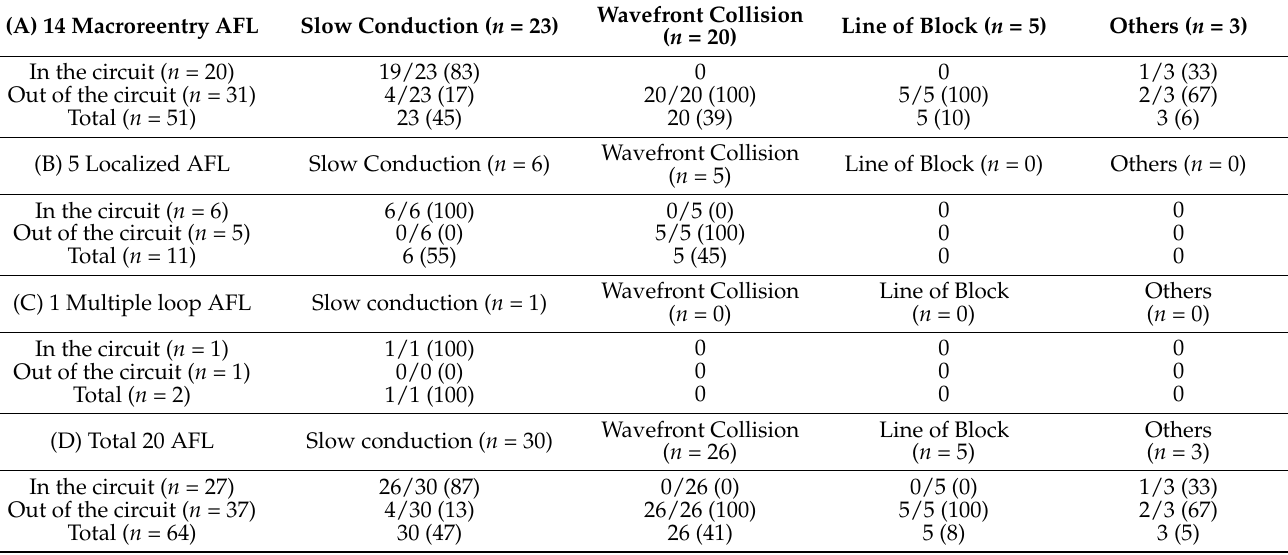
Table 3. Electrophysiological properties of highlighted areas based on the lowest